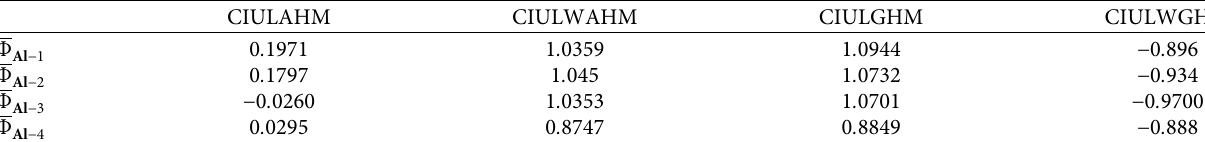
Table 6: Score values of each alternative from the aggregated values by different operators.